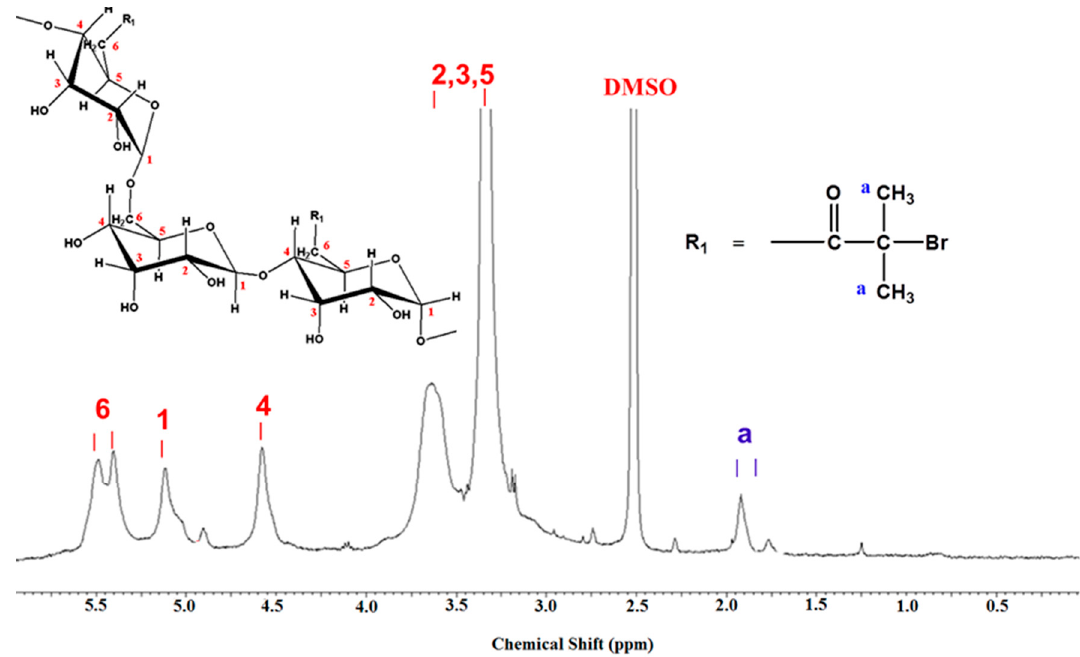
Figure 3. 1 H NMR spectra of starch based macroinitiator (St ‐ Br).